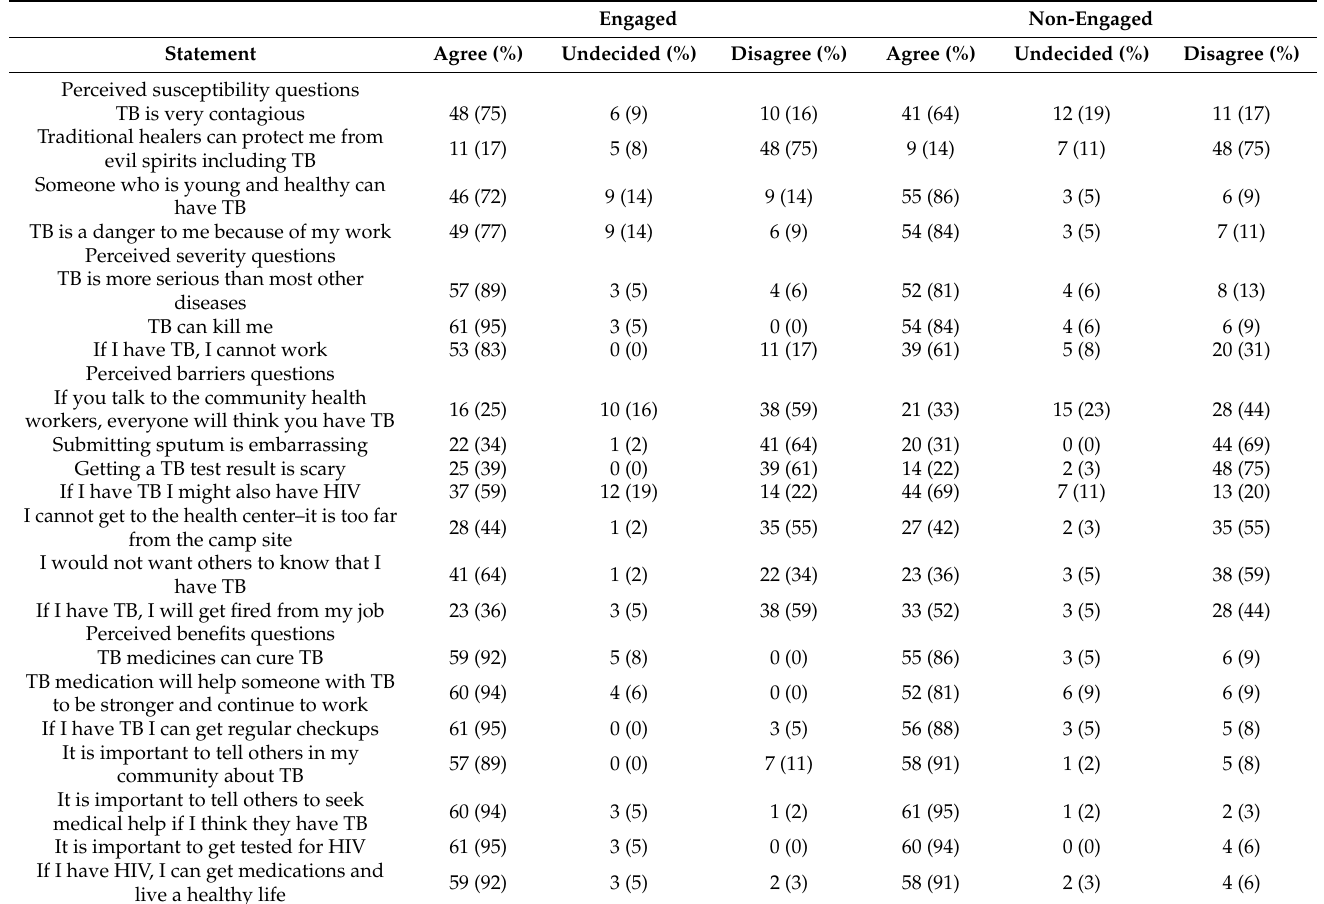
Table 2. Likert scale question responses of engaged and non-engaged groups.